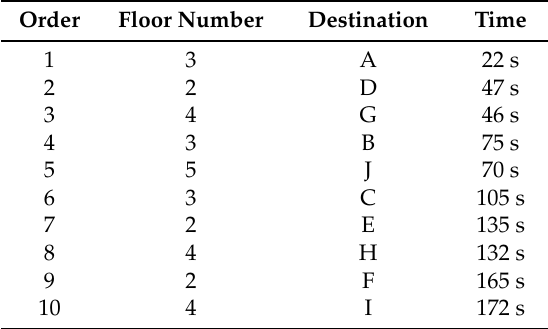
Table 7. The actual arrival times of MACSI to the 10-nearest lavatories in the real dataset. Order Floor Number Destination Time 1 3 A 22 s 2 2 D 47 s 4 G 46